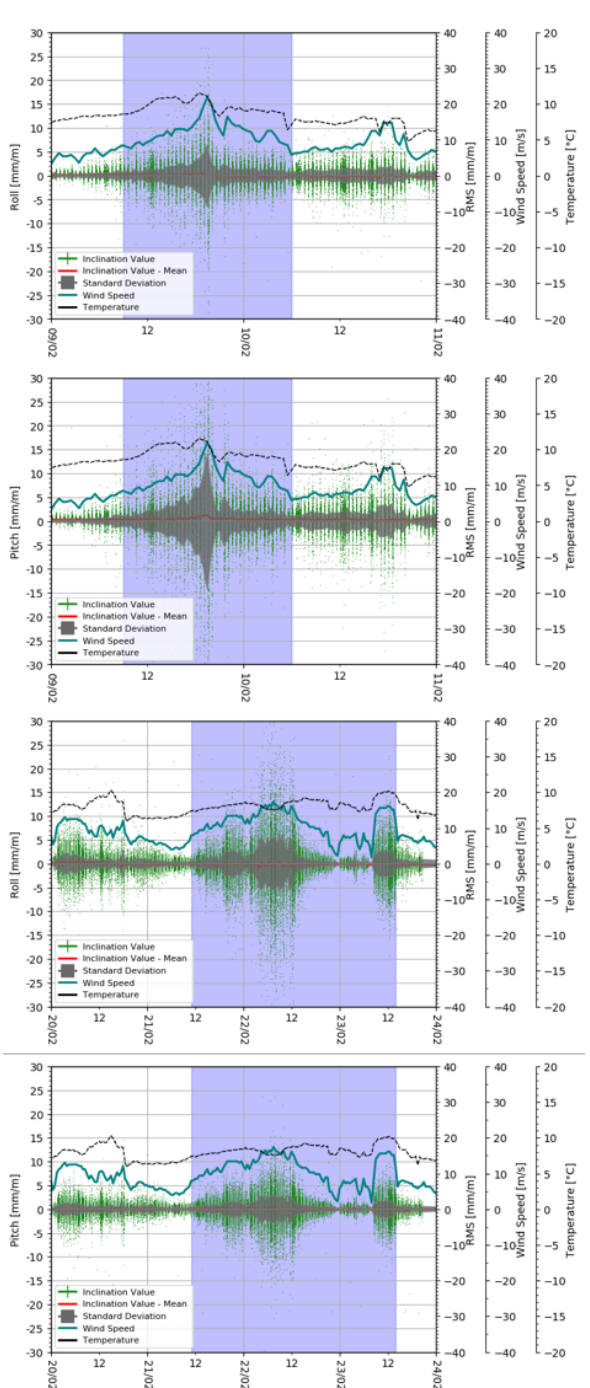
Figure 4. Internal inclination values during observation periods around storm Ciara (two top panels) and storm Yulia (two bottom panels). The stormy periods are marked with a blue background. Raw data, mean values and standard deviations of the inclination data are compared to temperature and wind speed.